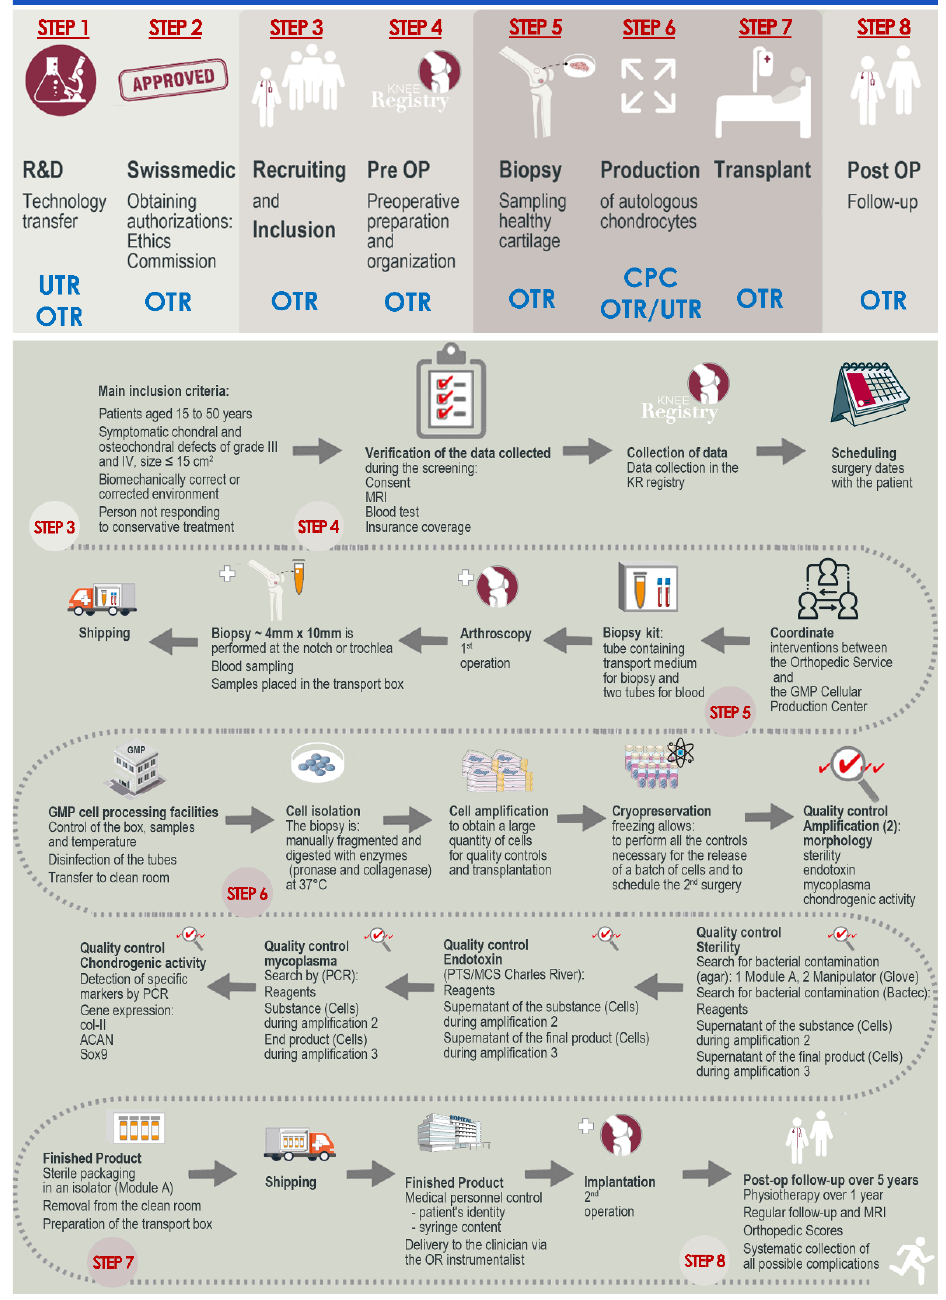
Figure 1. Schematic dual (i.e., general and detailed) multi-step process overview of the development and implementation steps for the considered HAC-based injectable cytotherapeutic products for ACI, within the context of the authorized clinical trial in the CHUV. ACI, autologous chondrocyte implantation; CHUV, centre hospitalier universitaire vaudois; CPC, cell production center; GMP, good manufacturing practices; HAC, human articular chondrocytes; MRI, magnetic resonance imaging; OTR, orthopedics and traumatology service; PCR, polymerase chain reaction; UTR, regenerative therapy unit.